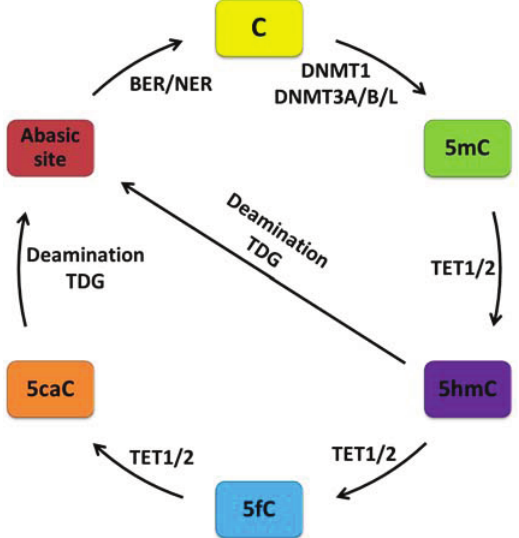
Figure 1. The life-cycle of DNA methylation in mammalian cells. The nucleotide cytosine (C) is methylated at the 5th carbon either by the DNA maintenance methyltransferase 1 (DNMT1) during DNA replication or de novo by DNA methyltransferase DNMT3A or DNMT3B. The catalytic inactive member DNMT3L enhances the activity of de